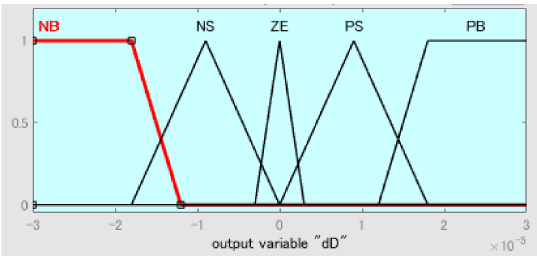
Figure 16. Wind turbine FLC output membership function for ∆ D